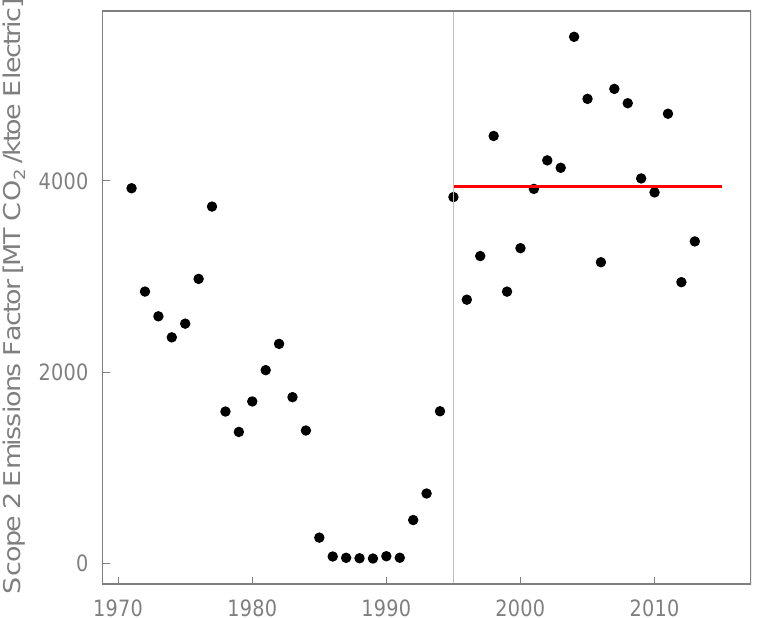
Figure 7. CO 2 emissions associated with electricity generation in Honduras from 1971 to 2013. Horizontal line at 3942 MT CO 2 /ktoe of electricity indicates the average efficiency from 1995 to 2013, which was assumed to be the primary-to-final efficiency of electricity production from 2013 to